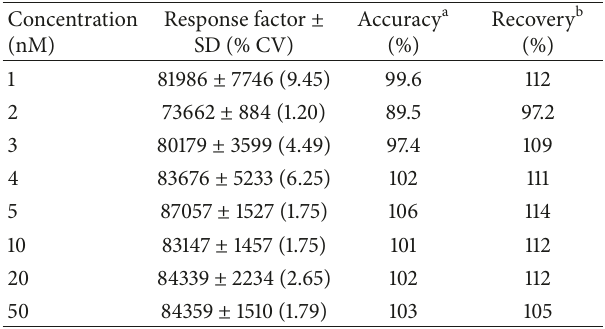
Table 1: Mean response factors, coefficients of variation (CV), accuracy, and recovery of pentosidine at various concentrations in human urine.